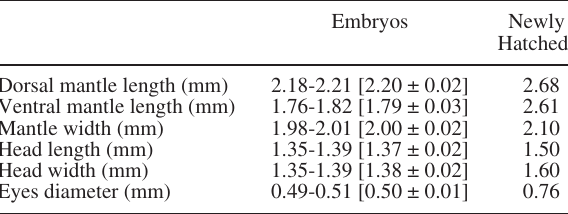
Table 1. – Sepietta oweniana from the Sardinian waters: measure- ments of six embryos (in bracket mean values ± SD) and one newly hatched specimen described in this paper.